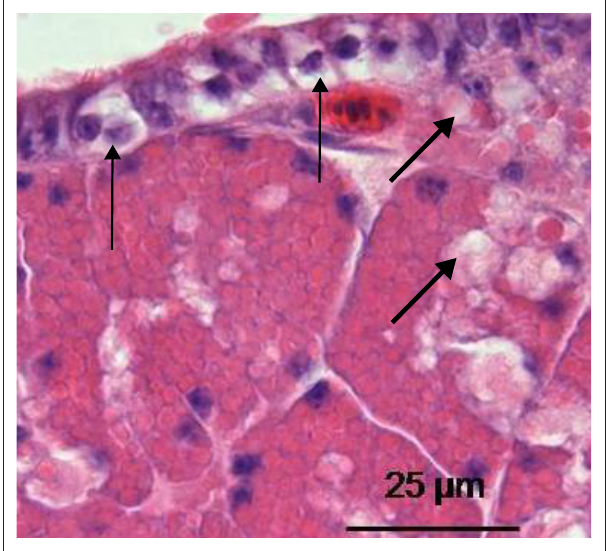
Thin arrows, cells exhibiting pale cytoplasm; Thick arrows, numerous vacuoles in gland cells. FIGURE 4: Photomicrograph of magnum from a bird treated with carbendazim at a dose of 800 mg/kg bodyweight.